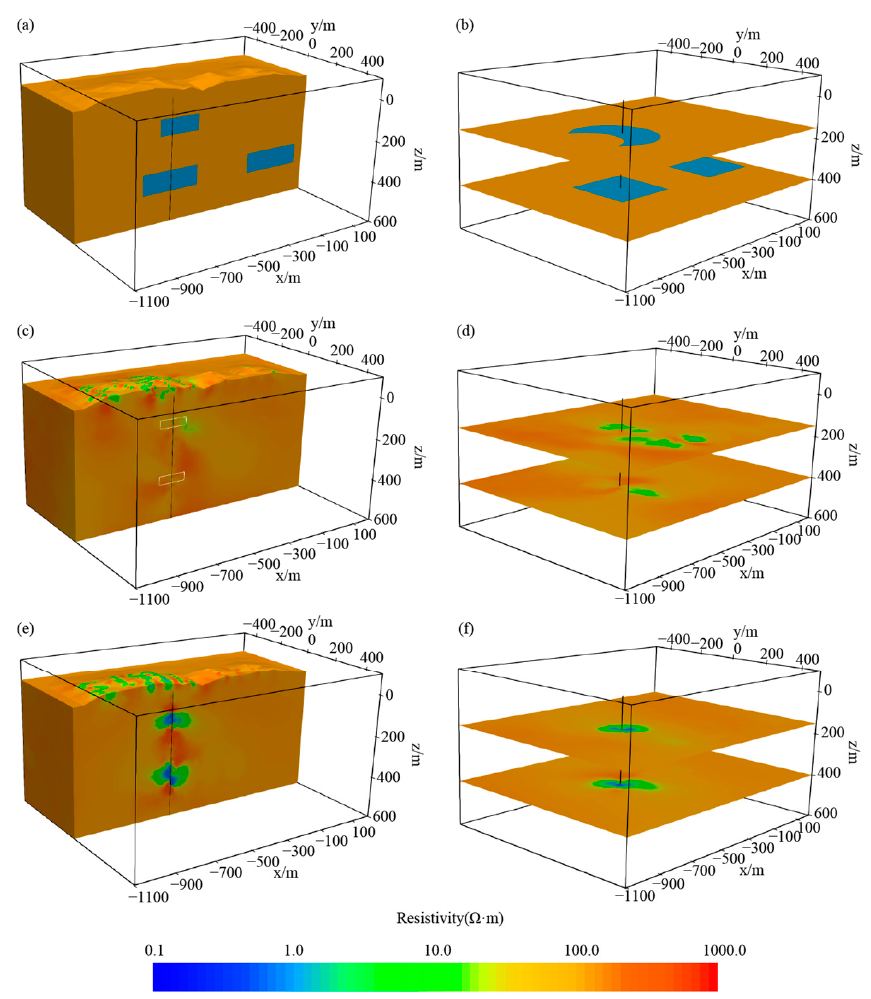
Figure 10. True model and inversion results from the dual-mesh and conventional methods: ( a , b ) true model; ( c , d ) conventional inversions; ( e , f ) dual-mesh inversions.